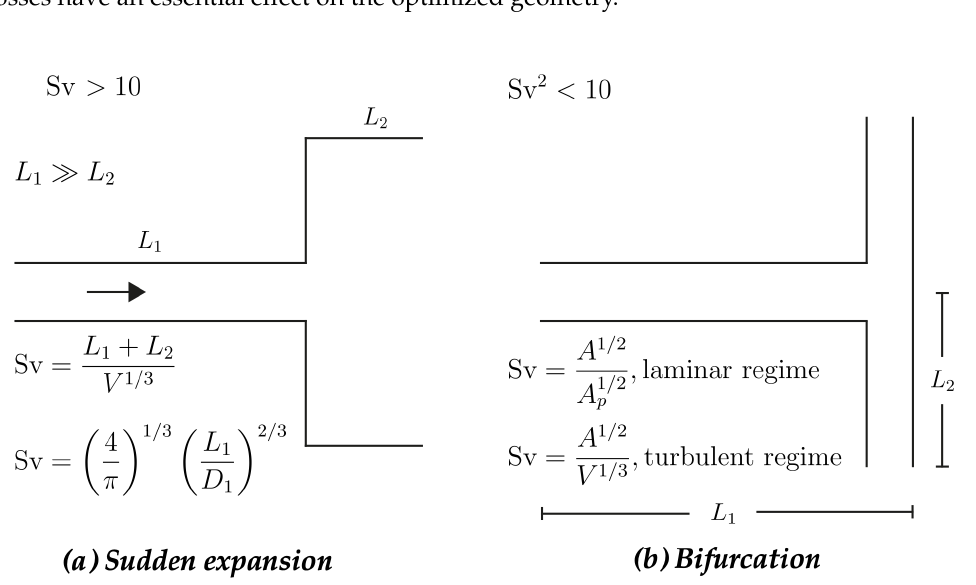
Figure 1. Geometry and related Sv function of the criteria to neglect or consider local pressure